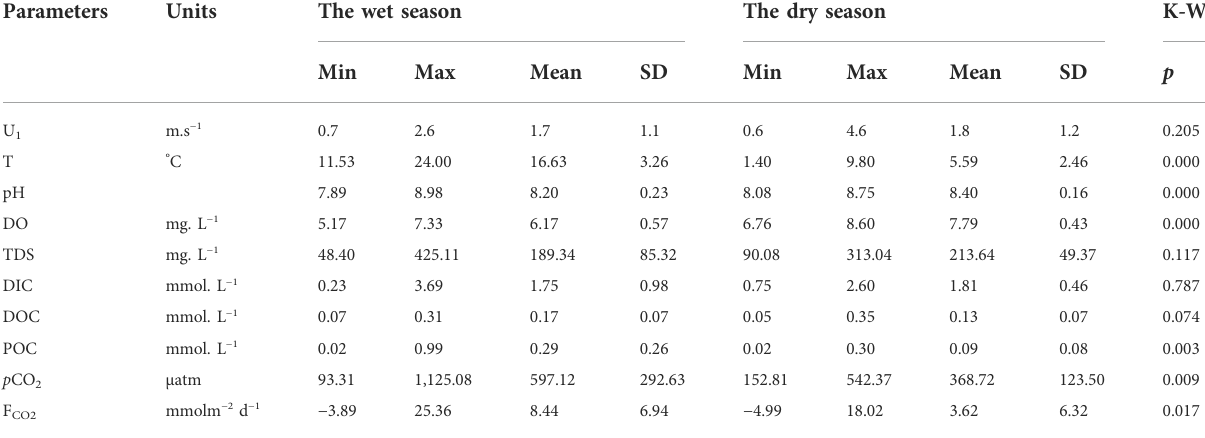
TABLE 1 Statistics of physicochemical